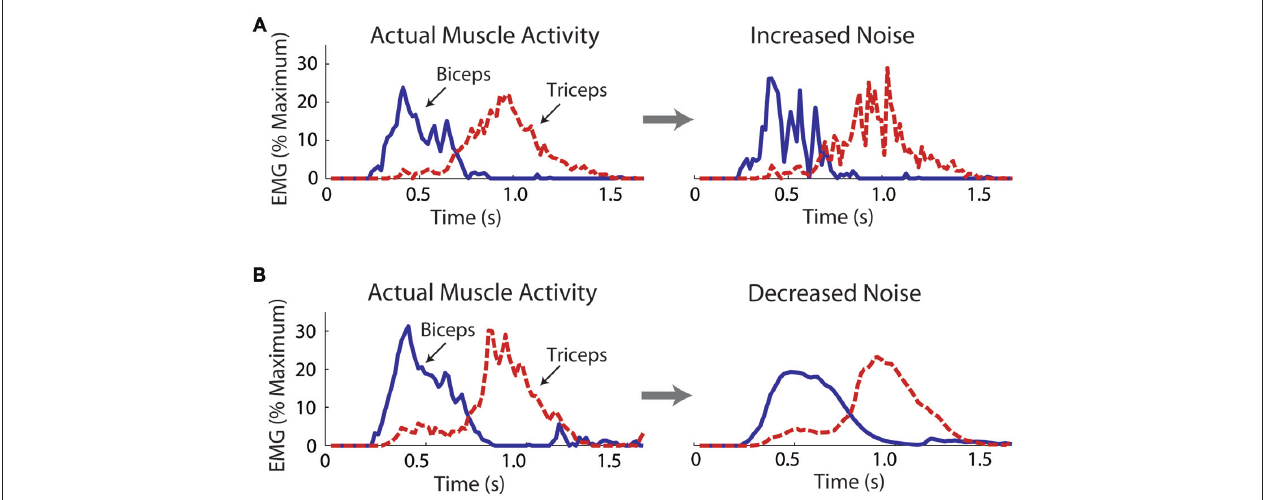
FIGURE 2 | Exemplar data from one subject showing actual and manipulated muscle activity during the virtual arm task. Noise was increased by adding noise to the muscle excitation linear envelopes before these signals activated muscle models, which produced forces to move the virtual arm (A) . Noise was decreased by applying a low-pass filter (B)